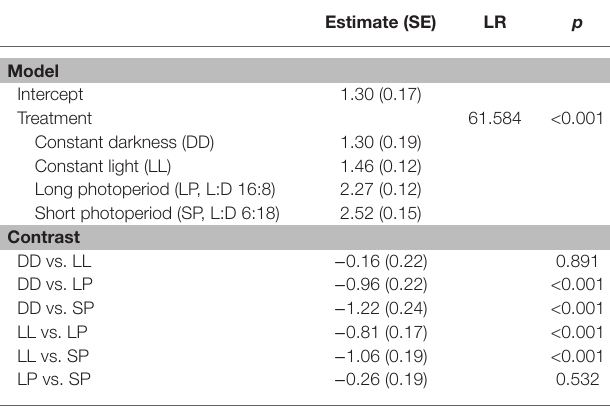
TABLE 1 | Differences in body temperature amplitude (i.e., the difference between the daily core T b peak and T b nadir; ° C) under different photoperiods.